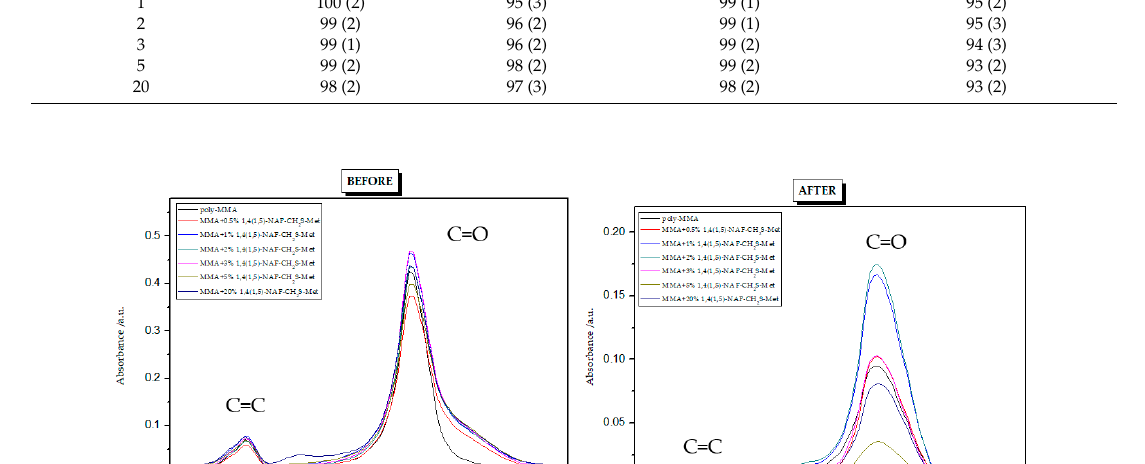
Table 3. Degree of conversion (%) of studied polymers.